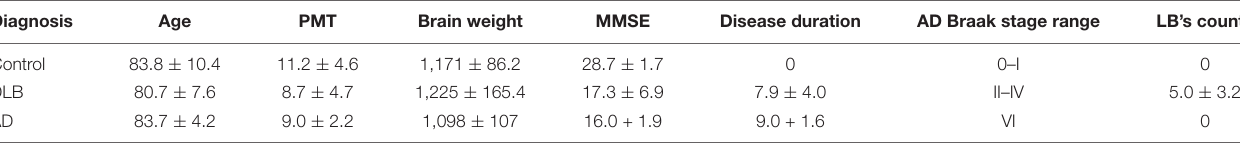
TABLE 1 | Human samples used for this study with neuropathological evaluation and criteria for diagnosis.